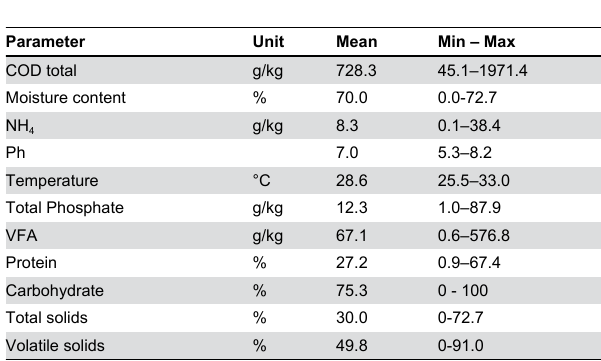
Table 1. Characteristics of latrine superstructure and use of 42 latrines sampled in and around Ifakara, Tanzania, July– August 2011.